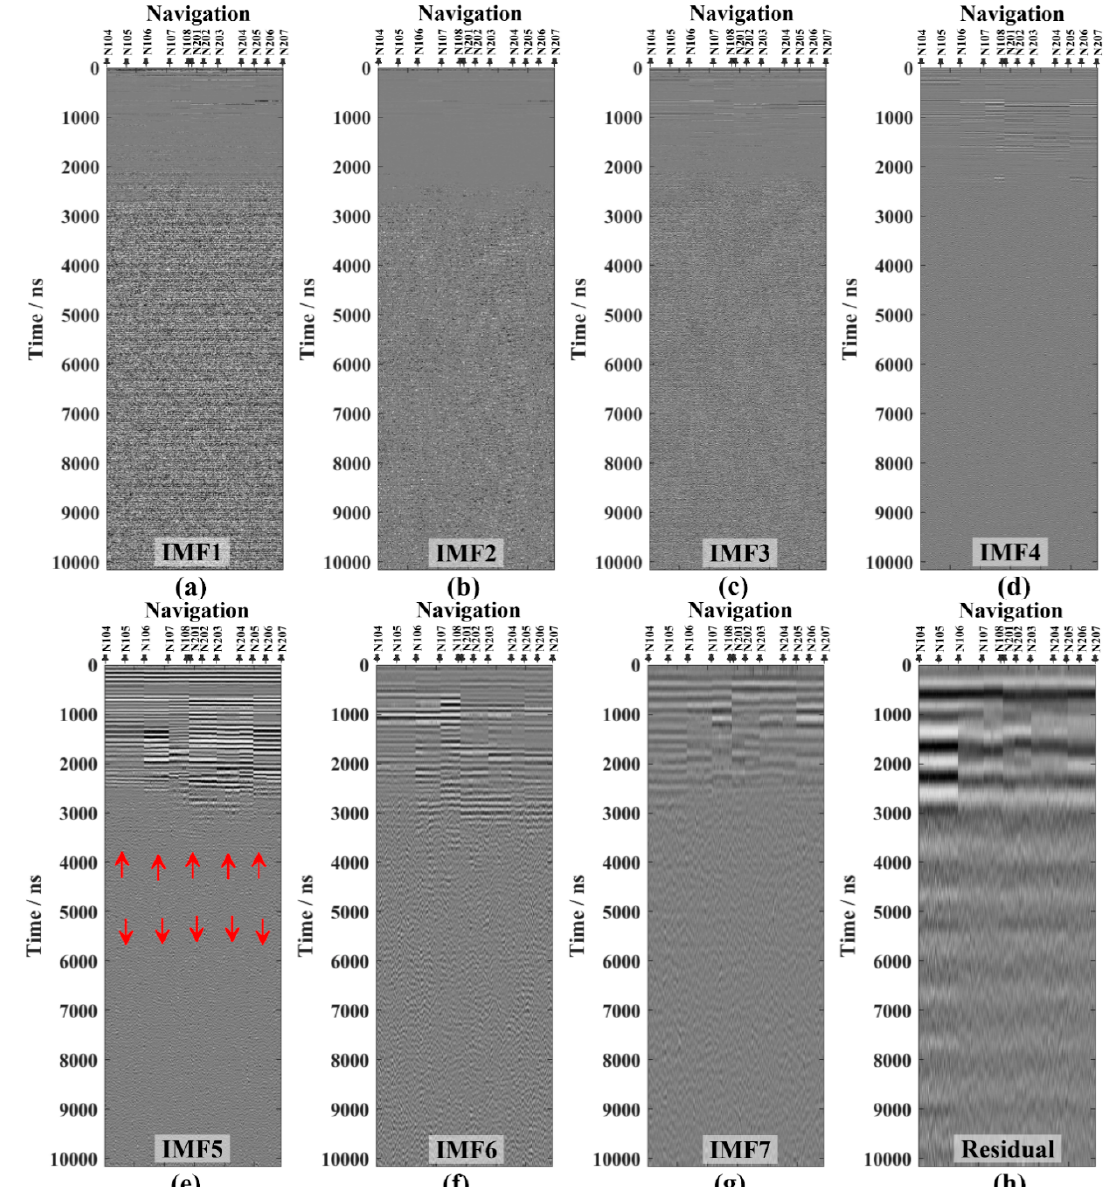
Figure 10. IMFs of LPR CH-1 overall data. ( a ) IMF1. ( b ) IMF2. ( c ) IMF3. ( d ) IMF4. ( e ) IMF5. ( f ) IMF6. ( g ) IMF7. ( h ) Residual.